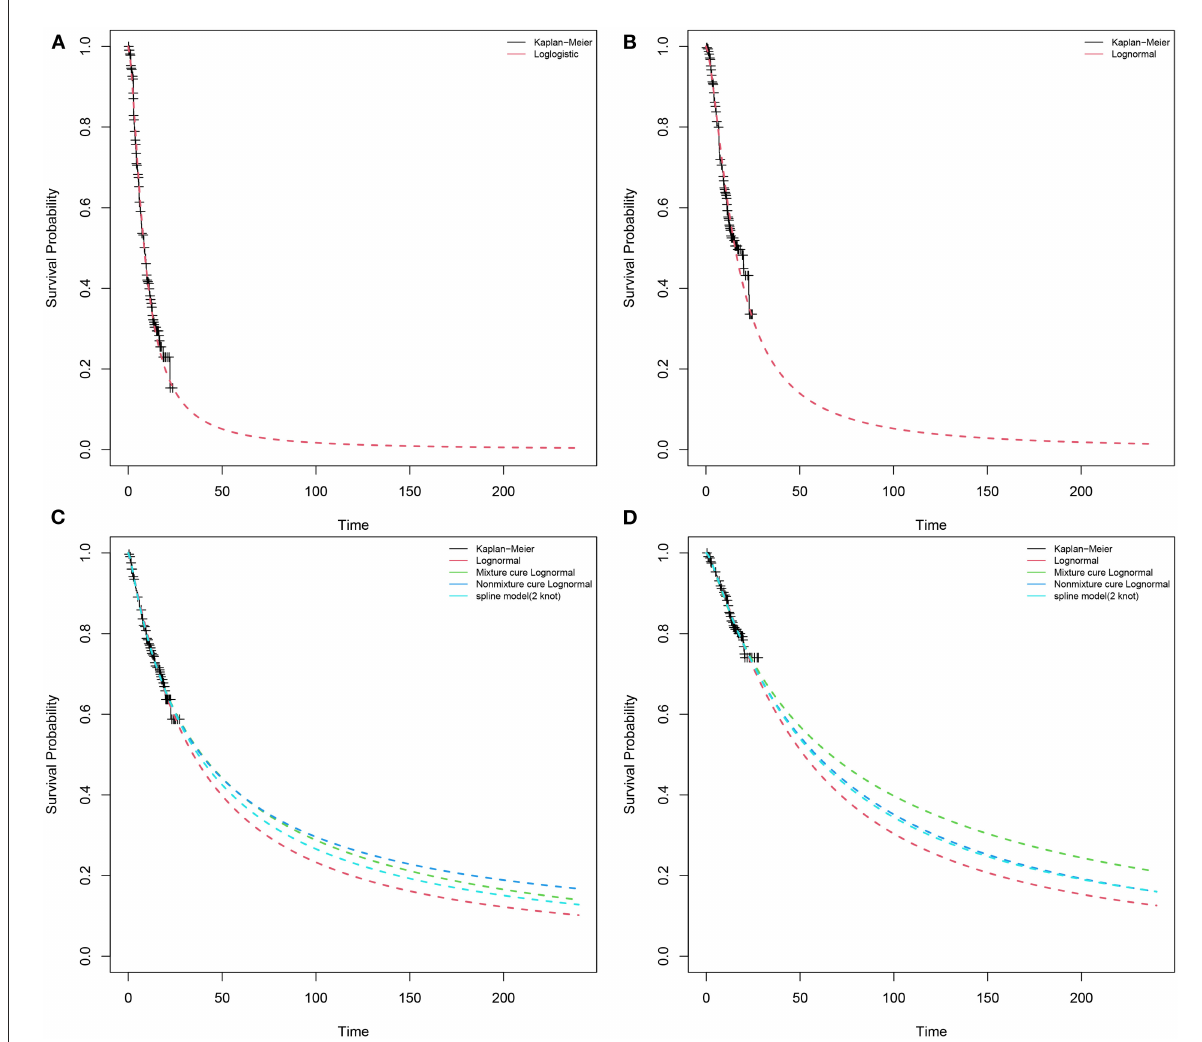
FIGURE2 Results of the survival curve fit the NI + CA and sunitinib strategy of the base-case analysis in the partitioned survival model. (A) PFS of sunitinib strategy, (B) PFS of NI + CA strategy, (C) OS of sunitinib strategy, (D) OS of NI + CA strategy.